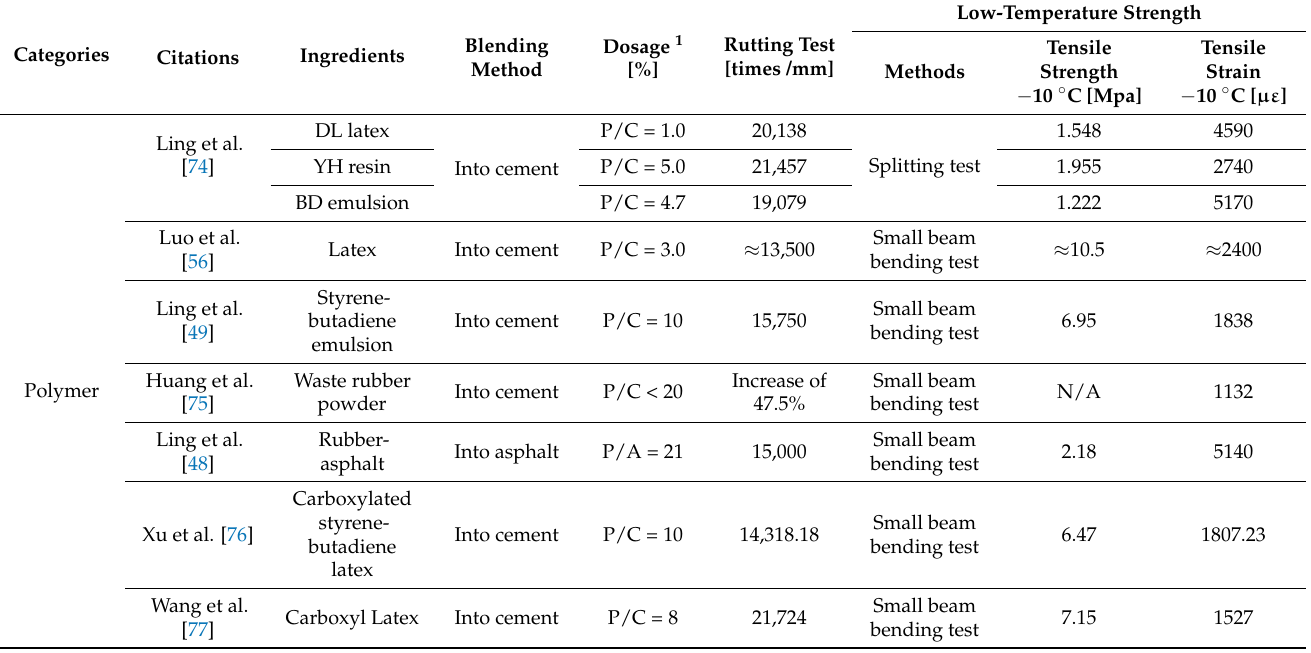
Table 9. Admixtures and their effects on